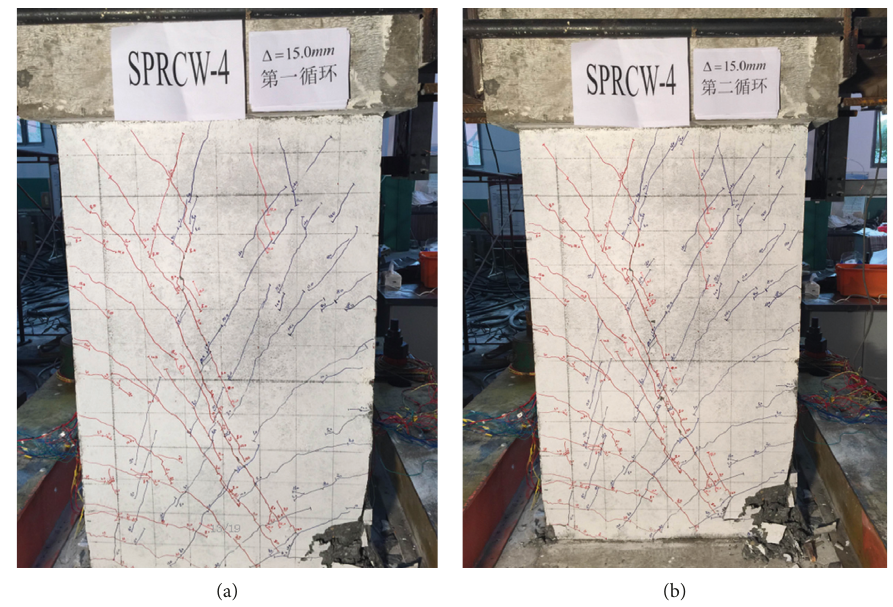
Figure 22: Diagram of cracks in the Δ � 15mm displacement cycle. (a) First cycle. (b) Second